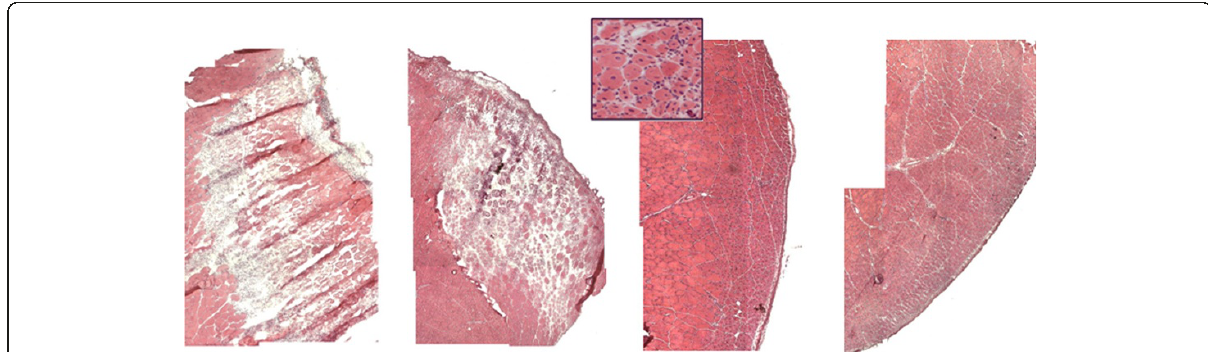
Figure 4 Kinetics of skeletal muscle regeneration following focal injury in mouse. Hematoxilin and eosin staining (H&E) of murine Tibialis anterior muscle (only a portion of the muscle is shown) subjected to freezing by applying a liquid nitrogen-cooled steel forceps to the surface (facing right in the picture) of the muscle for 10 seconds. The muscle was collected and analyzed 3, 6, 8 and 10 days following injury (from left to right). The inset shows a higher magnification image of regenerating fibers 8 days after injury: hallmarks of regenerating fibers include reduced fiber size and centrally located